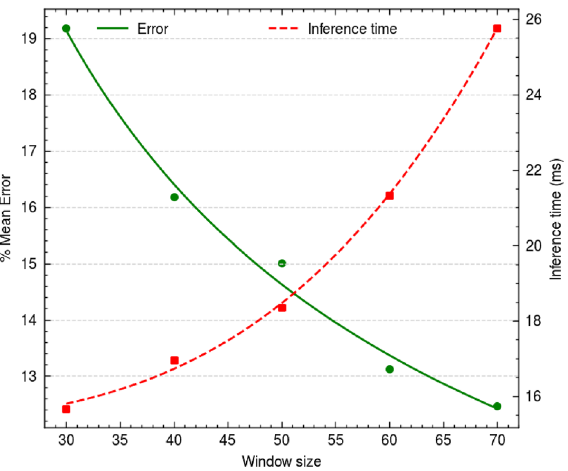
Figure 5. Benchmarking results on the NCBI Virus Data Hub influenza dataset.